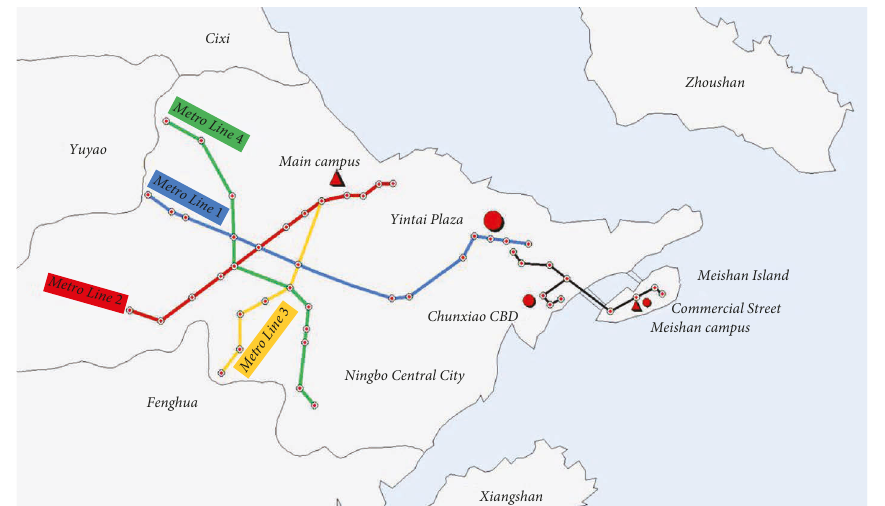
Figure 2: Location of Ningbo